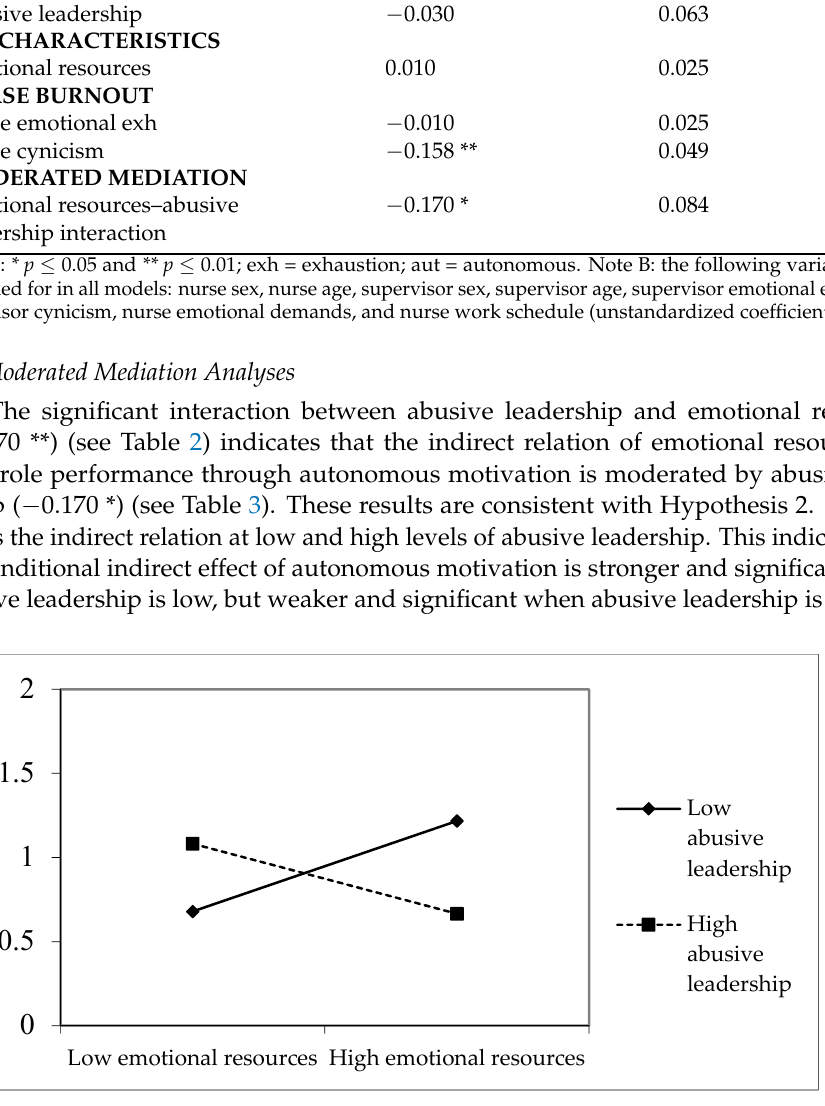
Figure 2. Interaction effect of emotional resources and abusive leadership on nurse autonomous motivation.